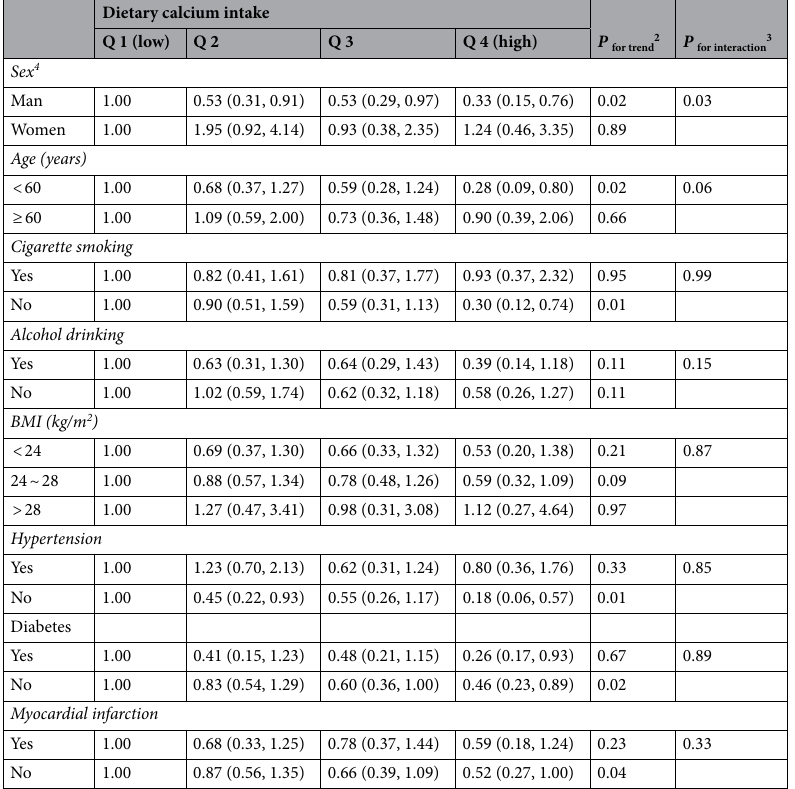
women, protective factors are more likely to be observed in riskier environments. Hence, our study found a stronger association between male intake and stroke, not in women. As for magnesium intake with stroke, no significant association was found in the Nurses’ Health Study 10 or the Swedish Mammography Cohort 30 . Similarly, in some randomized trials, magnesium supplementation did not reduce blood pressure in normotensive volunteers 46 . A high magnesium diet was observed to increase rather than decrease the risk of stroke in hypertensive rats 47 . Our study was consistent with previous studies in which the relationship between dietary magnesium intake and stroke. In both animal models and clinical studies, phos- phorus intake affects the release of PTH and fibroblast growth factor-23 (FGF-23), both of which may increase oxidative stress in endothelial cells, lead to arterial calcification 48 and endothelial dysfunction 49 . According to a recent opinion in European Heart Journal, excess dietary phosphorus intake contributes to cardiovascular disease by raising serum phosphorus concentrations 50 and indirectly support a preventive impact of phosphorus on the risk of stroke. However, no prominent relationship between dietary phosphorus and stroke risk was observed in our study. Given the sparse evidence, more compelling researches are necessary to reveal the association between dietary phosphorus intake and stroke. As far as we know, there have been no studies on dietary calcium, magnesium, and phosphorus intake with stroke risk in the Chinese population. The major strengths of the present study include its large sample size and prospective design, which reduced the possibility of recall and selection biases. In addition, dietary data were collected before the occurrence of the disease so that disease status could not influence the self-report of diet. Furthermore, by calculating the cumulative average of dietary intakes, we minimized the measurement errors caused by a diet change over time and considered eating behavior changes. Some limitations of the present study are worth discussion as well. Firstly, the dietary assessment was a 24-h dietary recall, which only reflects the short-term dietary situation. However, the approach used was validated,